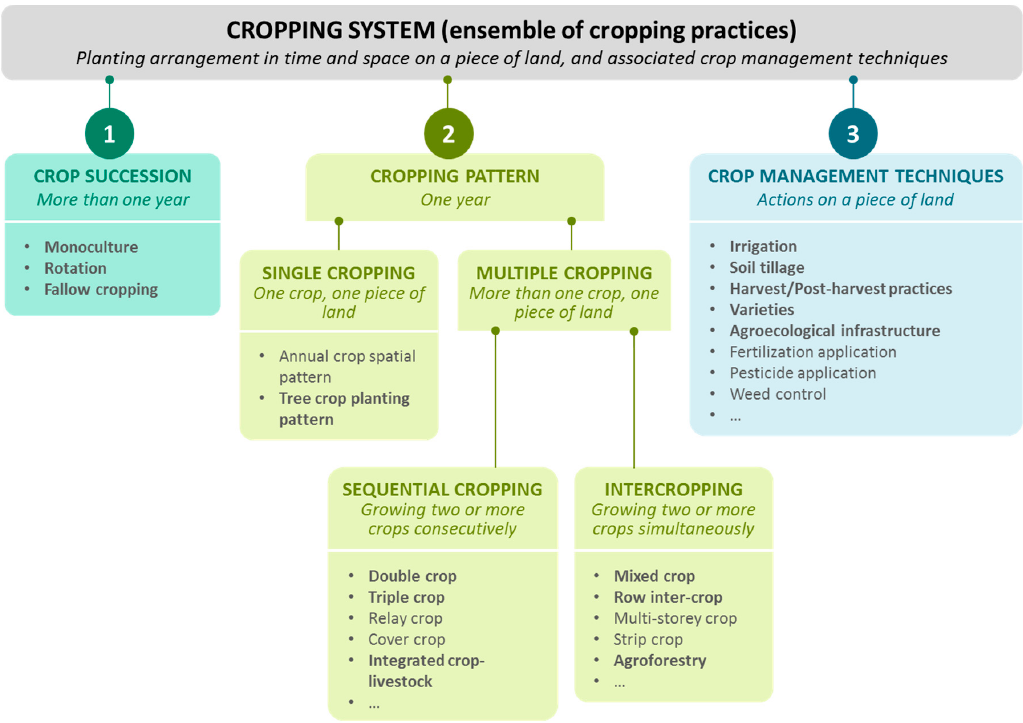
Figure 1. Typology and short definitions of the cropping system components, numbered 1 to 3, and associated cropping practices, as used in this paper. Bold terms indicate the cropping practices that are reviewed in this paper.